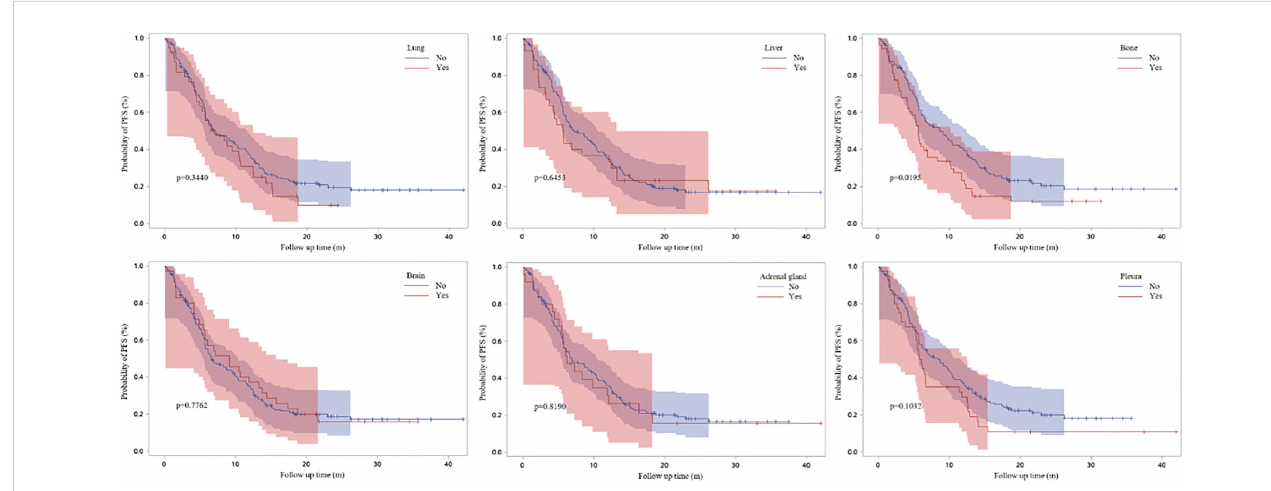
FIGURE 3 Survival curves based on Kaplan-Meier for different metastatic sites at